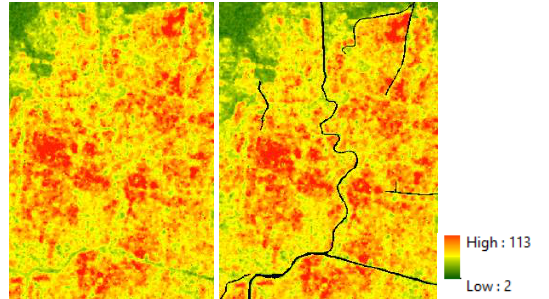
Figure 2. DTM data of Surabaya (b) Existing river overlaid with